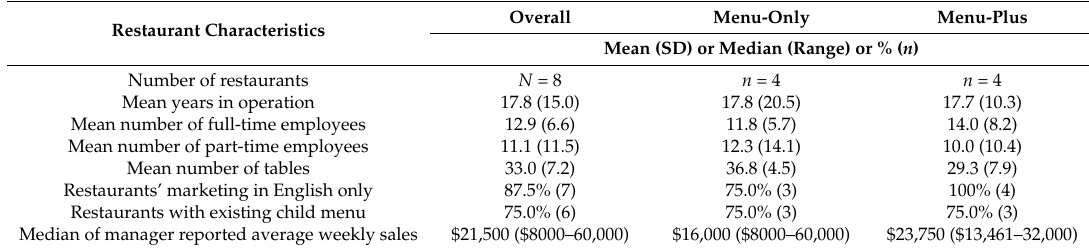
Table 1. Kids’ Choice Restaurant Program baseline restaurant characteristics.